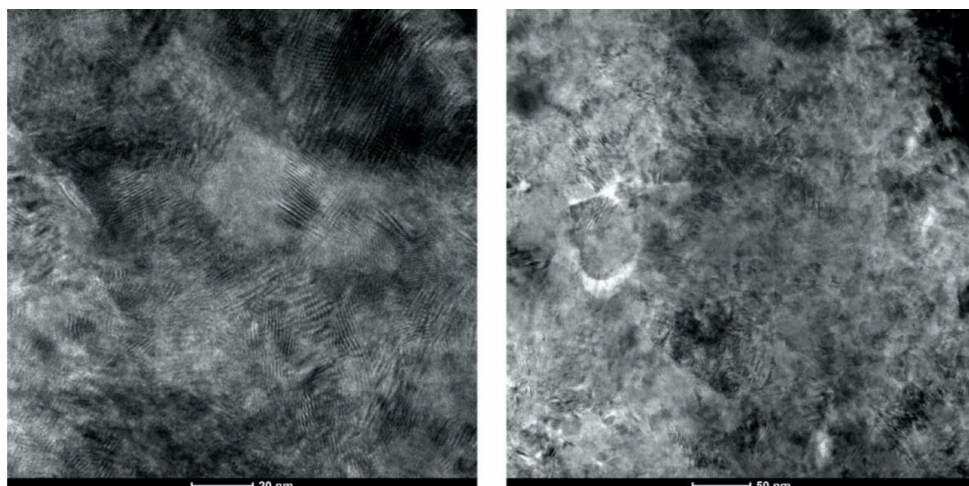
Figure 23. STEM micrographs of the deformed microstructure of the nanostructured cold sprayed coatings in the cross-sectional orientation. Increased dislocation density can be observed in parts of the micrograph on the left. A large amount of atomic lattice fringes is observed in the leftmost